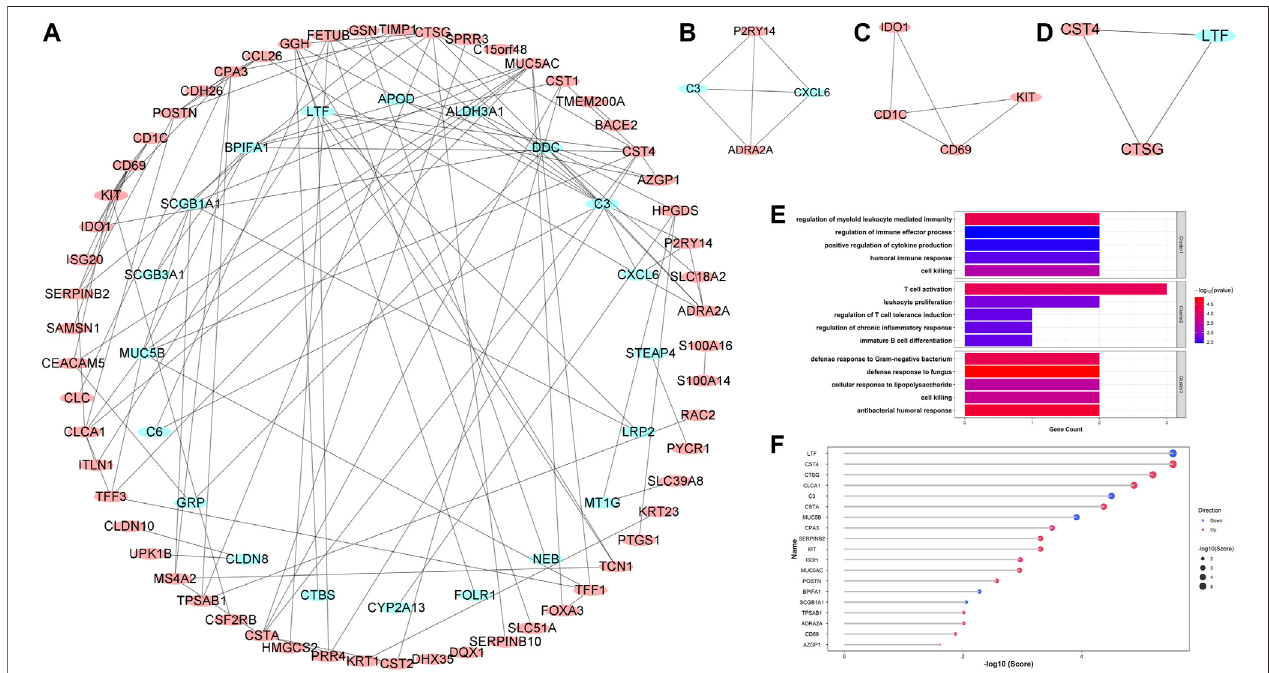
FIGURE 5 | Protein-protein interaction (PPI) network construction, key clusters analyses, and hub genes identi fi cation. (A) The whole PPI network with all robust DEGs; (B) PPInetworkofCluster1; (C) PPInetworkofCluster2; (D) PPInetworkofCluster3.RedcirclesrepresentedupregulatedDEGs,whilebluecirclesrepresented downregulated DEGs. (E) The signi fi cantly enriched entries for the biological process of three clusters; (F) The lollipop chart showed all hub genes identi fi ed by the RRA method. The red and blue dots represented the up- and down-regulated hub genes, respectively. Bigger dots represented higher ranks.